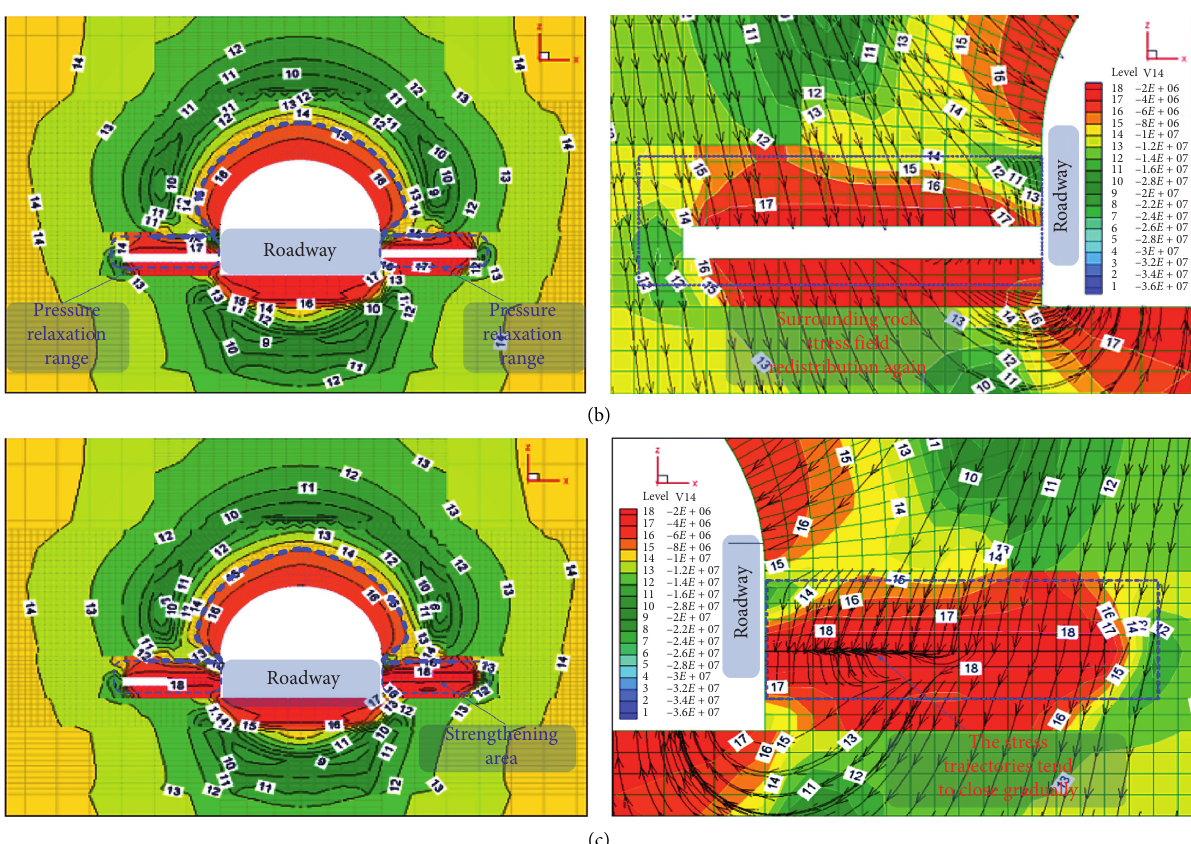
Figure 14: Distribution and path vector graphs of surrounding rock stresses: (a) distribution state of surrounding rock stress after ex- cavation; (b) distribution state of surrounding rock stress unloading measures; (c) distribution state of surrounding rock stress after reinforcement measures.